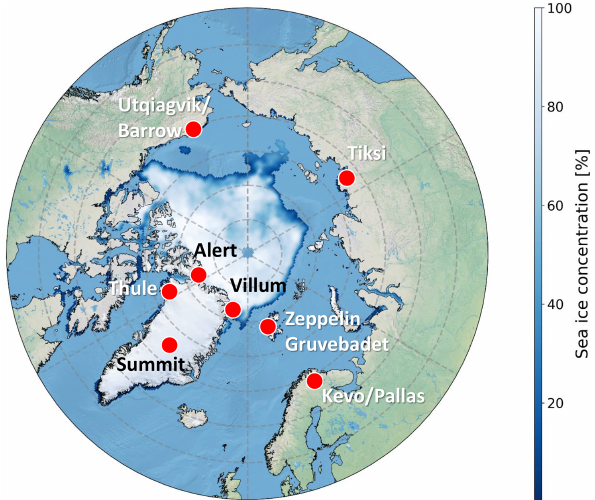
Figure 1. Locations of observatories discussed in this study. The blue shading represents sea ice concentration (15 Septem- ber 2018), reported as a fraction of covered surface (Maslanik and Stroeve, 1999). The base map is from Natural Earth II (https: //www.naturalearthdata.com/, last access: 1 March